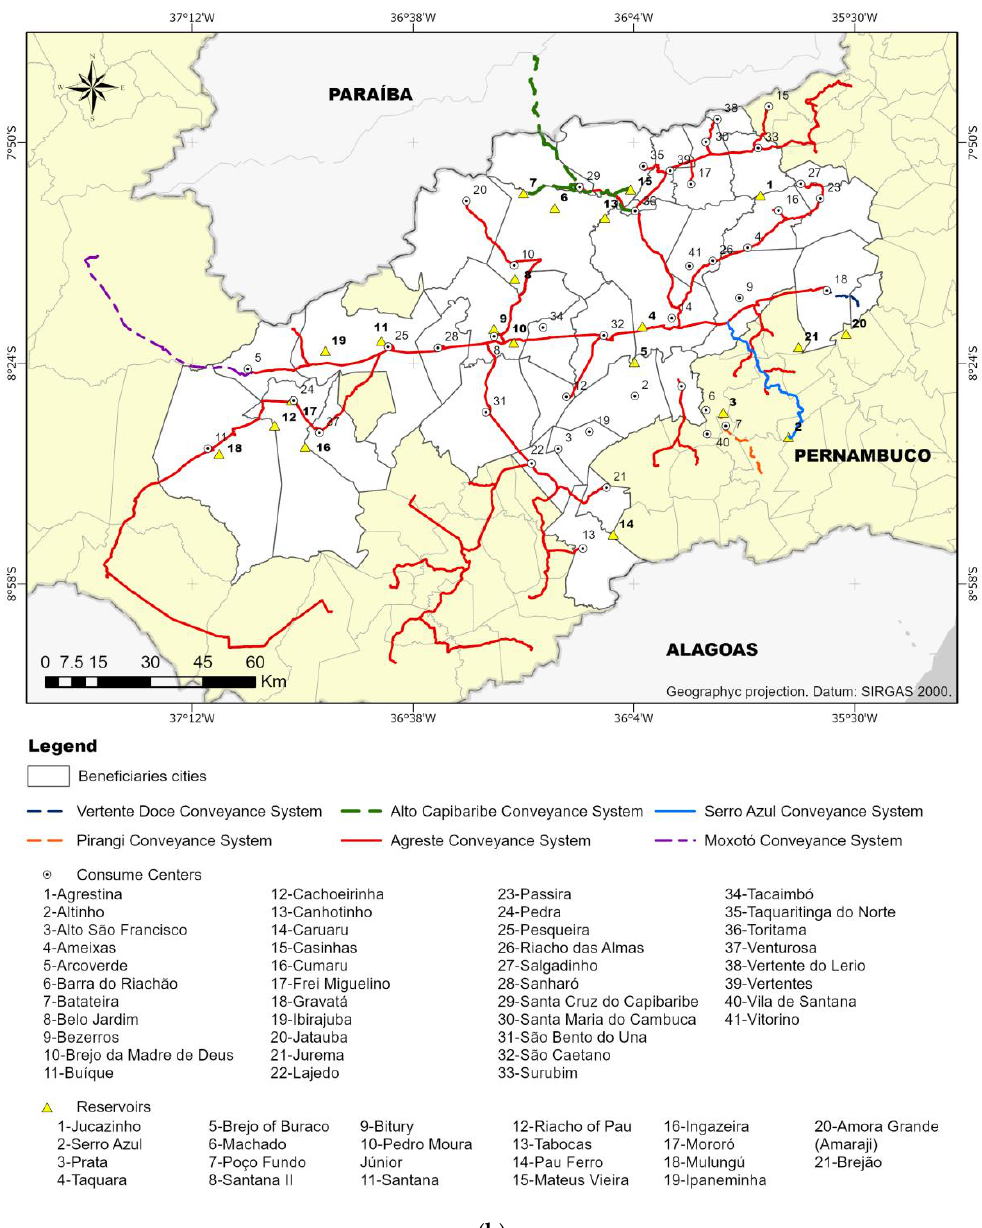
Figure 2. Discretization of the study area: ( a ) hydrological network and ( b ) pipeline system, channels, sources and consumption centers of the project.